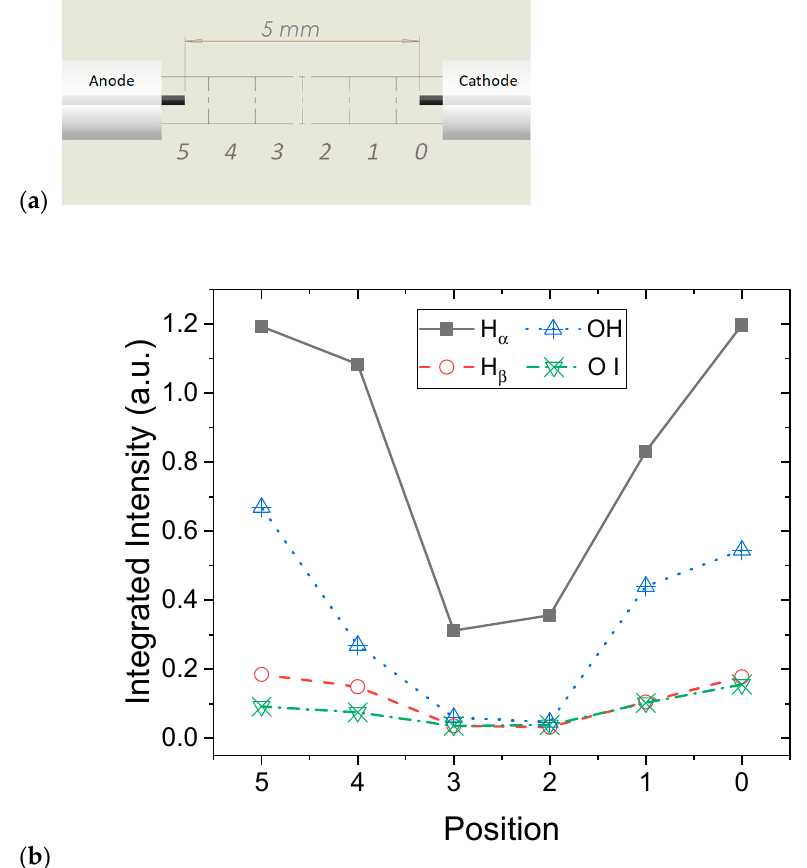
Figure 5. ( a ) Scheme showing the spatial resolution of the OES emission. ( b ) Integrated intensity according to the position between the electrodes for H α ( Δ λ = 650–666 nm), H β ( Δ λ = 483–493 nm), OH ( Δ λ = 610–630 nm), and O ( Δ λ = 774–783 nm).